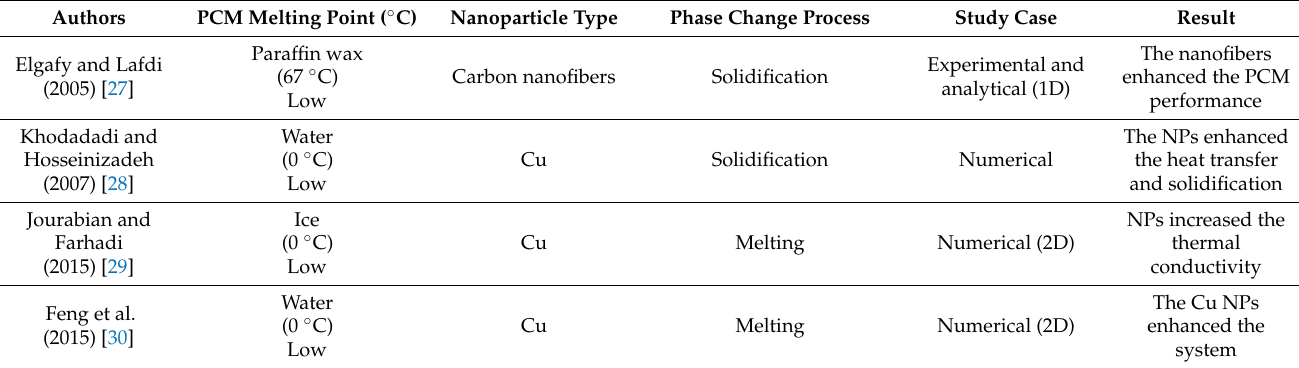
Table 1. A summary of studies that only used NPs to enhance the PCM thermal